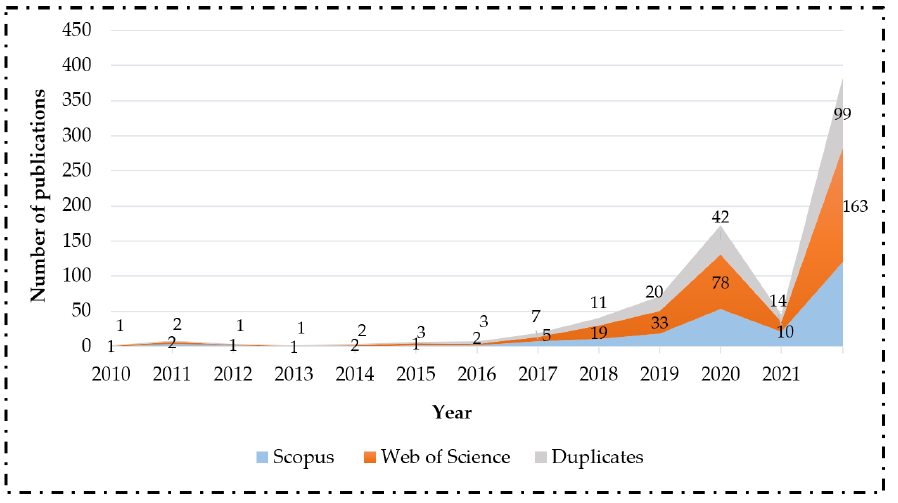
Figure 5. Yearly distribution of the retrieved articles.